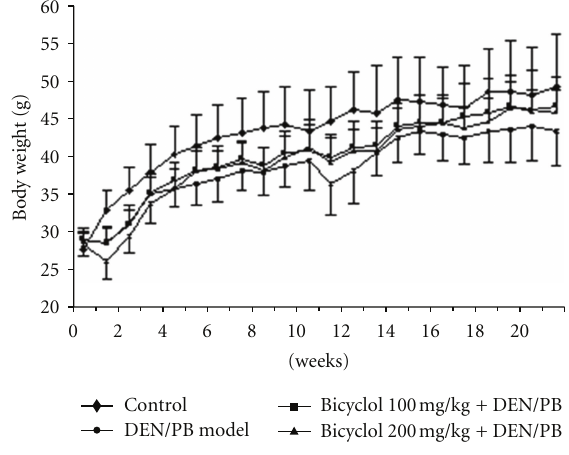
Figure 3: Body weight profile in the control and experimental groups. Average values with standard deviations are shown. n = 14-